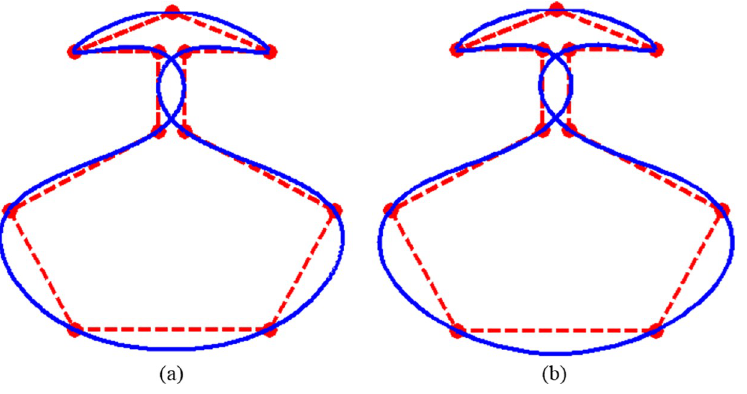
Fig 11. Data of a vase is interpolated: (a) by CPS; (b) by